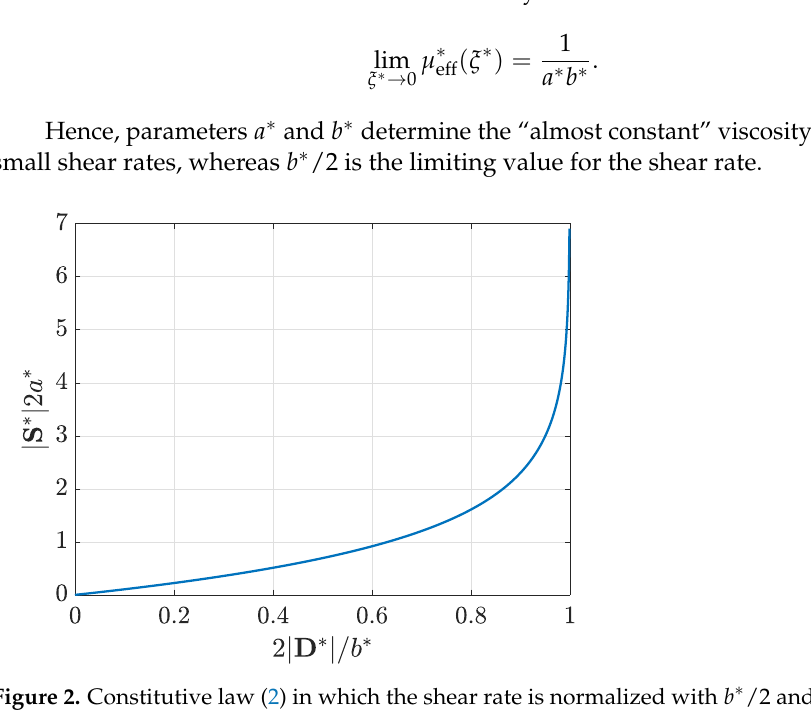
Figure 2. Constitutive law (2) in which the shear rate is normalized with b ∗ /2 and the shear stress with 1/2 a ∗